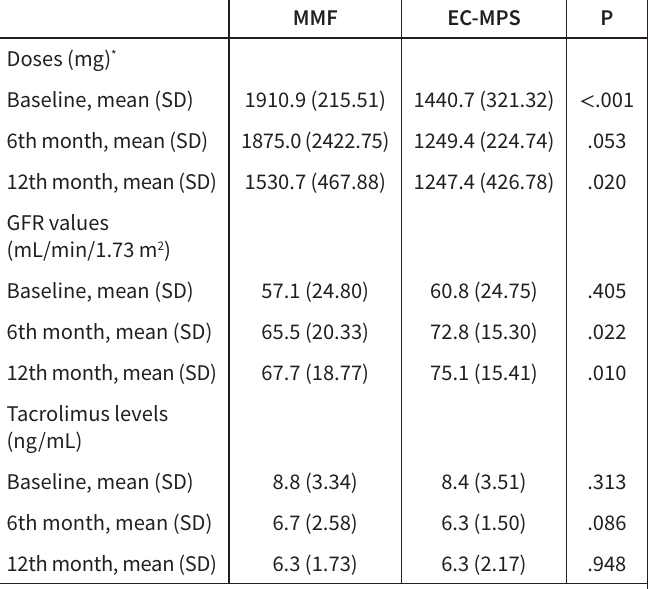
Table 2. Mean (SD) of Baseline, 6th Month, and 12th Month Doses, GFR Values, and Tacrolimus Levels